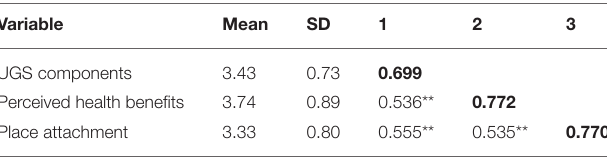
TABLE 3 | Descriptive statistics, correlations, and discriminant validity among the variables.